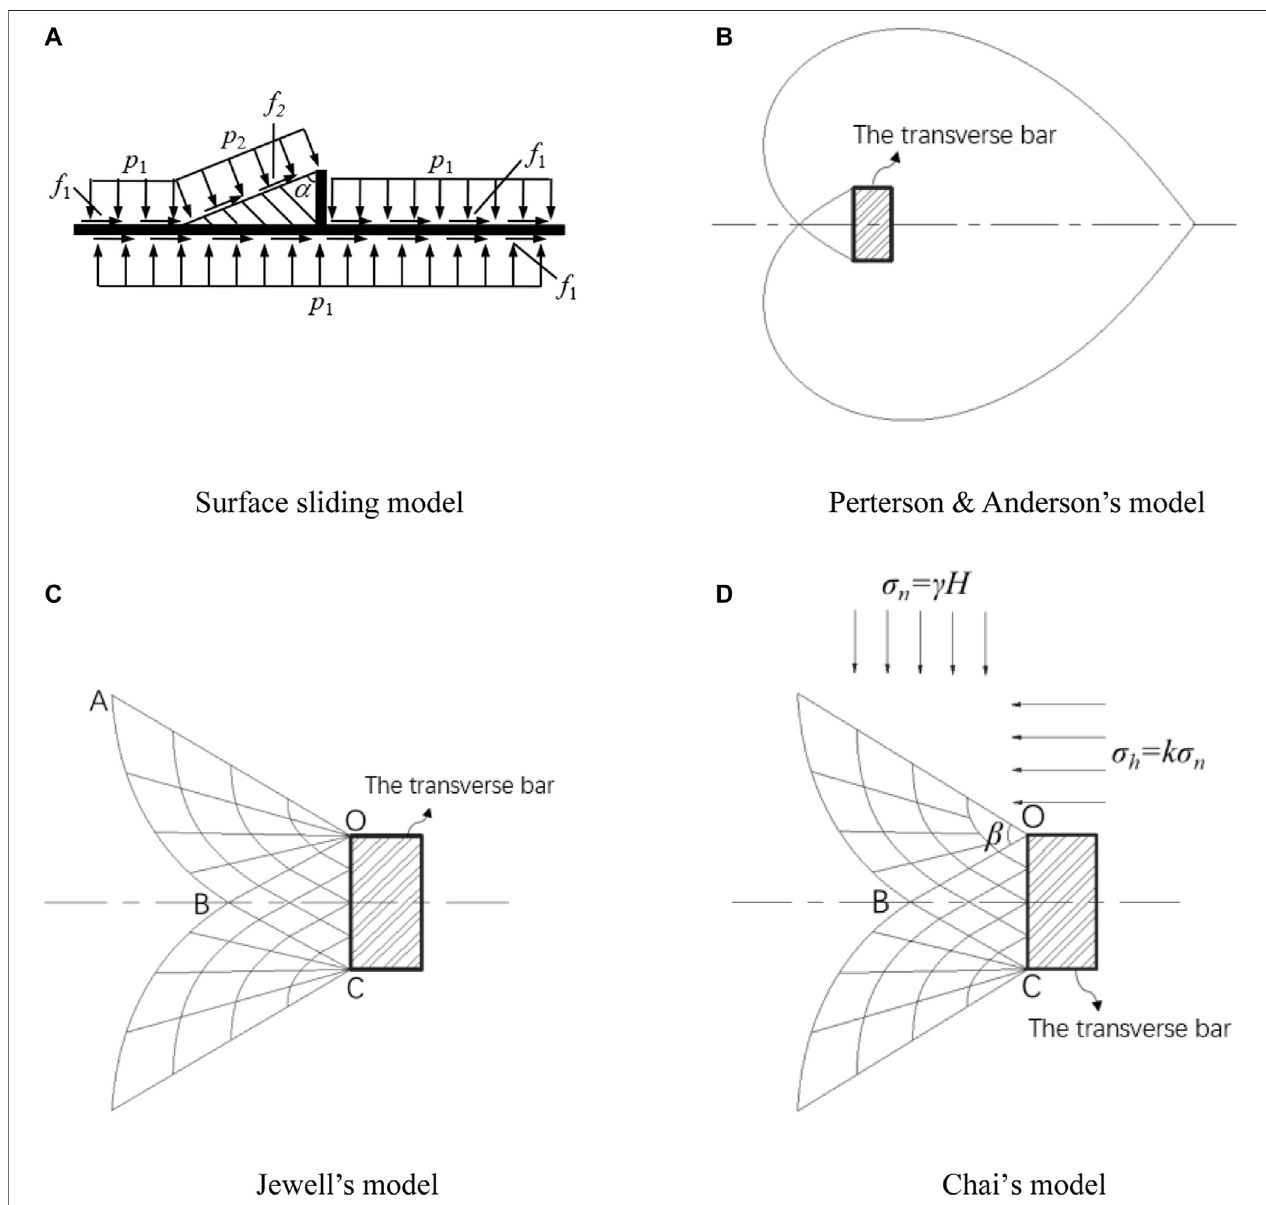
FIGURE 8 | Different pullout resistance models. (A) Surface sliding model. (B) Perterson & Anderson ’ s model. (C) Jewell ’ s model. (D) Chai ’ s model.